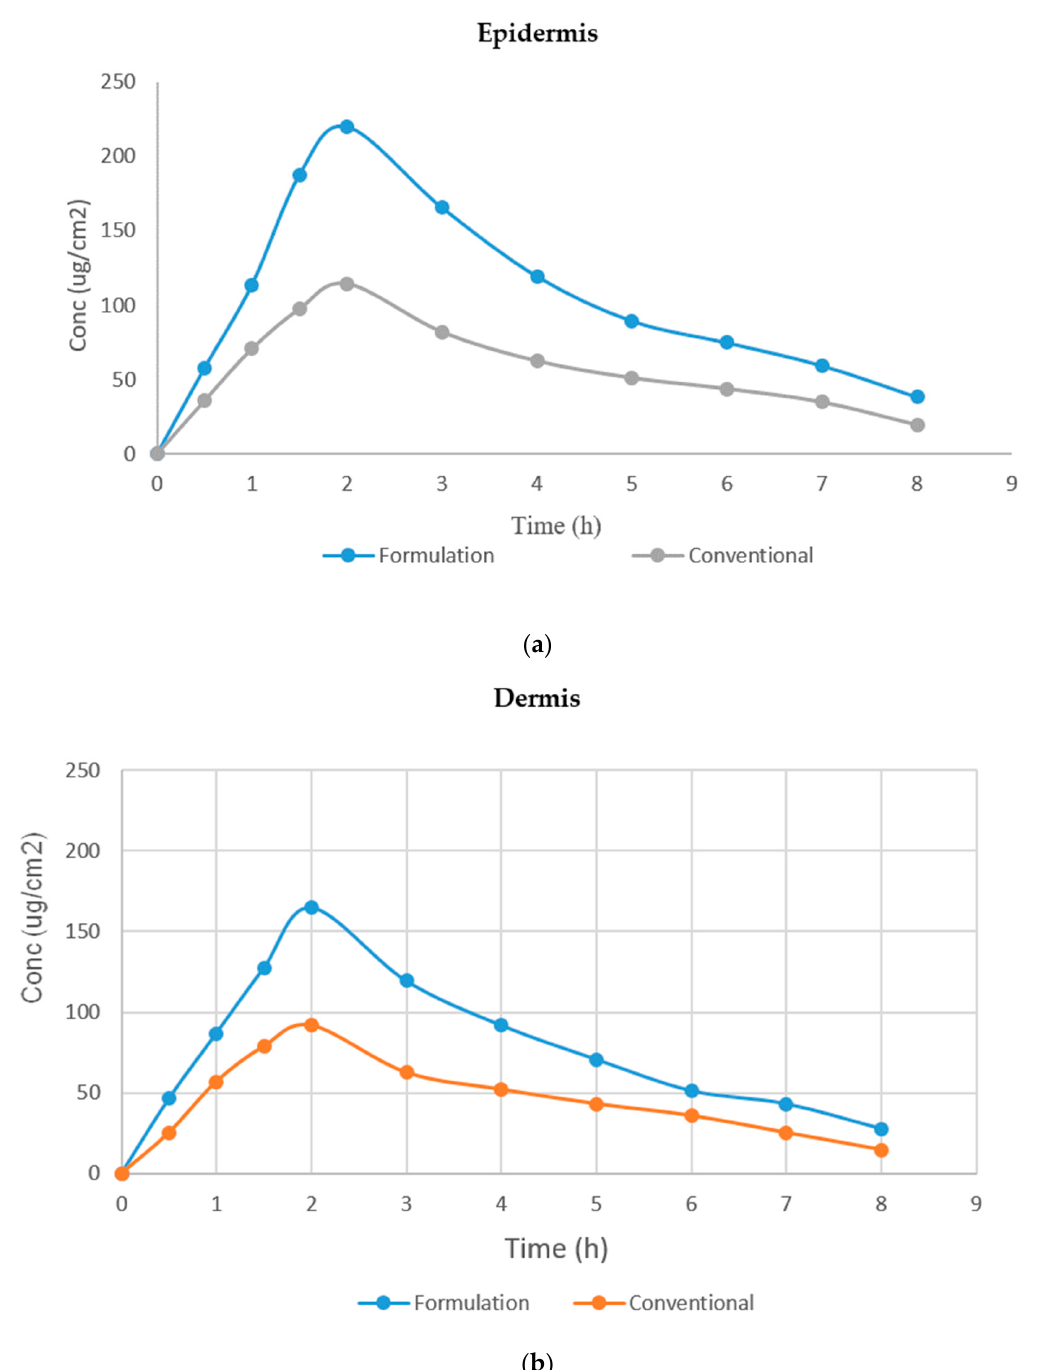
Figure 10. ( a ) Effect of Babchi oil nanoemulgel on epidermis concentration; ( b ) Effect of Babchi oil nanoemulgel on dermis concentration.